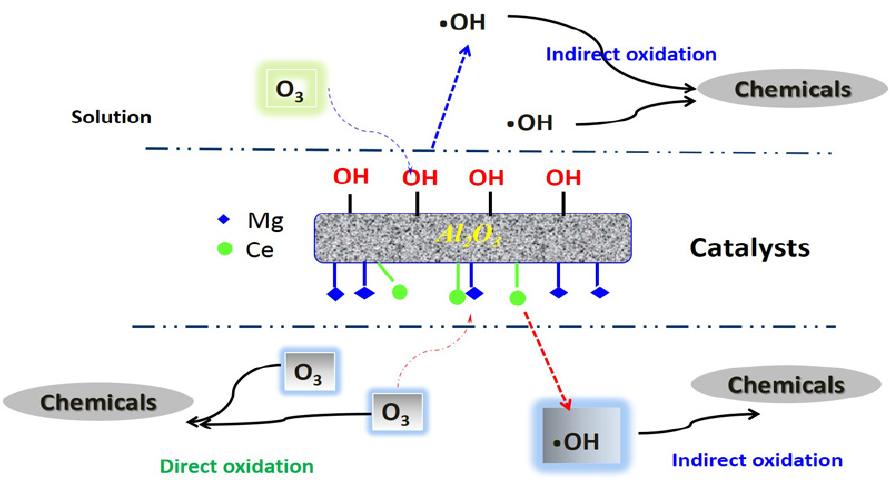
Figure 11. Proposed ozonation mechanisms of chemicals in RPRW upon metal oxide ‐ loaded Al 2 O 3